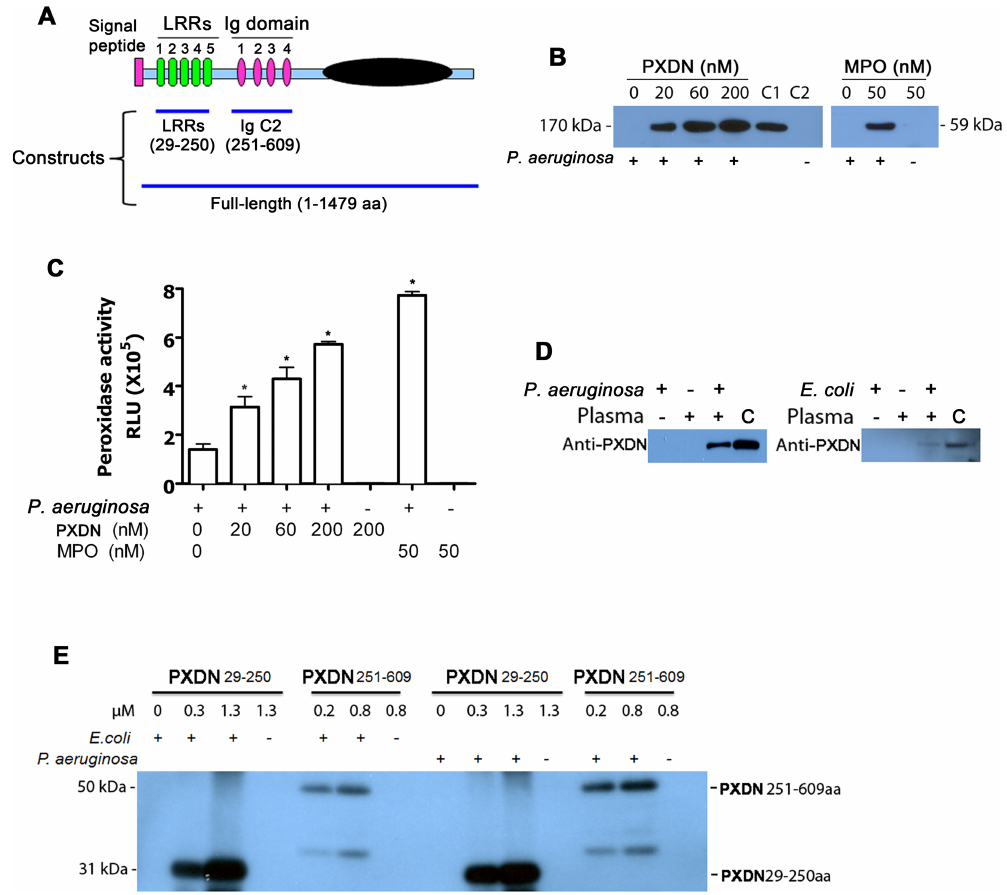
Fig 1. PXDN binds to GN bacteria. (A) Diagram of human PXDN and recombinant proteins of PXDN used in the study. All constructs for preparation of recombinant proteins of PXDN were polyhistidine-tagged either cloned in plasmid pET30 or pcDNA3.1. The subcloned region and related domain structure are indicated. (B) P . aeruginosa binds to full-length PXDN. P . aeruginosa strain K was added to PBS containing PXDN or MPO as indicated. The mixtures were incubated at 37˚C for 1 h. P . aeruginosa mixtures were centrifuged at 3099 x g for 5 min. The pellets were washed twice. One-half of the bacterial suspension was subjected to immunoblotting using anti-His antibody (left panel) or anti-MPO (right panel) antibody. C1 was PXDN positive control which was directly loaded. C2 was negative control in which 200 nM PXDN did not mixed with bacteria; it was centrifuged at 3099 x g for 5 min as experimental groups. (C) The remaining bacterial suspension in “B” was subjected to peroxidase activity assay using L-012 as chemiluminescent substrate. Note: MPO is known to bind to P . aeruginosa via its cationic charge, and served as a positive control in these experiments. (cid:3) P < 0.001 vs . bacteria only. Data are the representatives of at least three independent experiments. (D) E . coli and P . aeruginosa bind to plasma PXDN. 4 x 10 8 of E . coli K12 or P . aeruginosa strain K in 50 μL PBS were added to 50 μL human plasma. The mixtures were incubated at 37˚C for 1 h. Bacterial suspensions were spun down at 3099 x g for 5 min, and then washed twice with 500 μL PBS. Samples were subjected to immunoblotting using anti-PXDN antibody. “C” represents positive control of 1 μL of plasma containing 200 ng of PXDN, which was directly loaded onto the gel. Data are the representatives of three independent experiments. (E) Truncated PXDN binds to live P . aeruginosa and E . coli . Recombinant truncated peptides of PXDN 29-250aa or PXDN 251- 609aa were added to live bacterial suspensions of P . aeruginosa strain K and E . coli K12, respectively. The mixtures were incubated at 37˚C for 1 h. P . aeruginosa and E . coli suspension were centrifuged at 3099 x g for 5 min, and washed twice with PBS. The bacterial lysates were subjected to immunoblotting using anti-His antibody and visualized by chemiluminescence. A mixture containing only 1.3 μM of recombinant PXDN peptide without bacteria served as negative control (to verify no binding of PXDN peptide to the test tube). Data are representatives of three independent